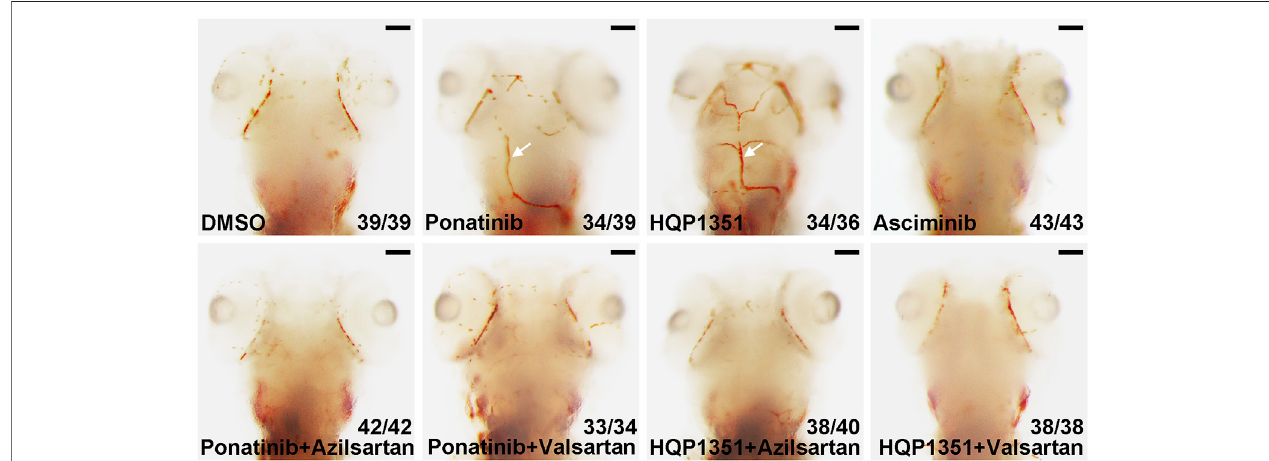
FIGURE 5 | Azilsartan and valsartan rescue ponatinib or HQP1351 induced cerebral thrombosis. Embryos were treated with the indicated drugs from 2 to 4 dpf and stainedwith o-dianisidine tovisualizecerebralthrombosis. Ponatinib (3 µM) orHQP1351(1 µM) induces cerebral thrombosis(white arrows)while asciminib(20 µM) doesnotinducethisdefect.PonatiniborHQP1351inducedcerebralthrombosiscanbepreventedbyco-treatmentofembryoswitheitherazilsartan(30 µM)orvalsartan (30 µM). Assays were repeated twice and the list numbers are the combined results. Scale bar: 100 µm.